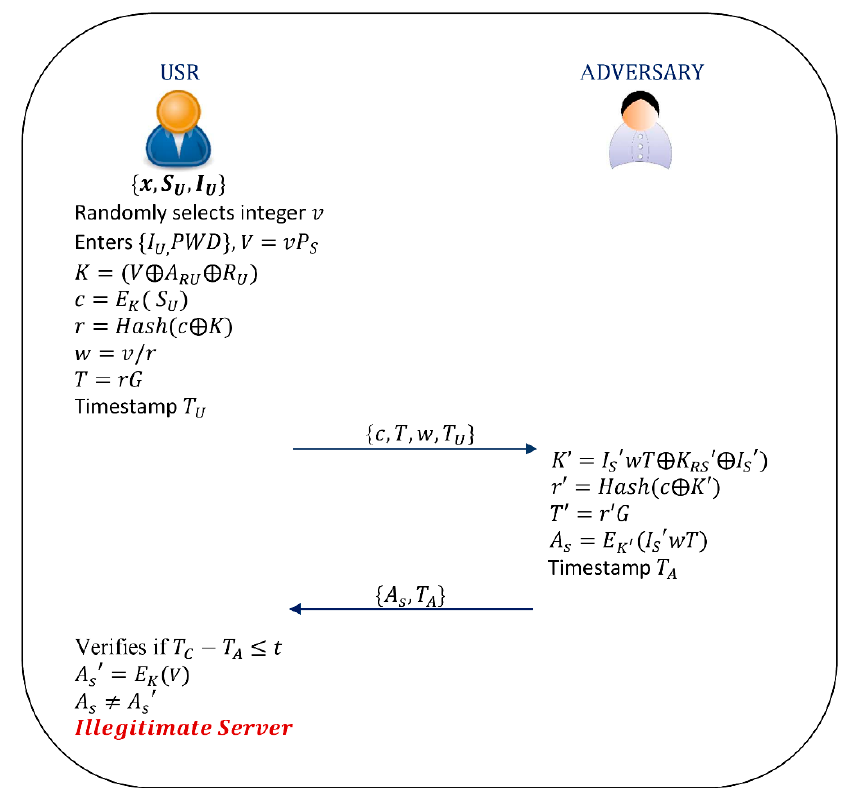
Figure 8. Resistance to server impersonation in ECSSP-SC.